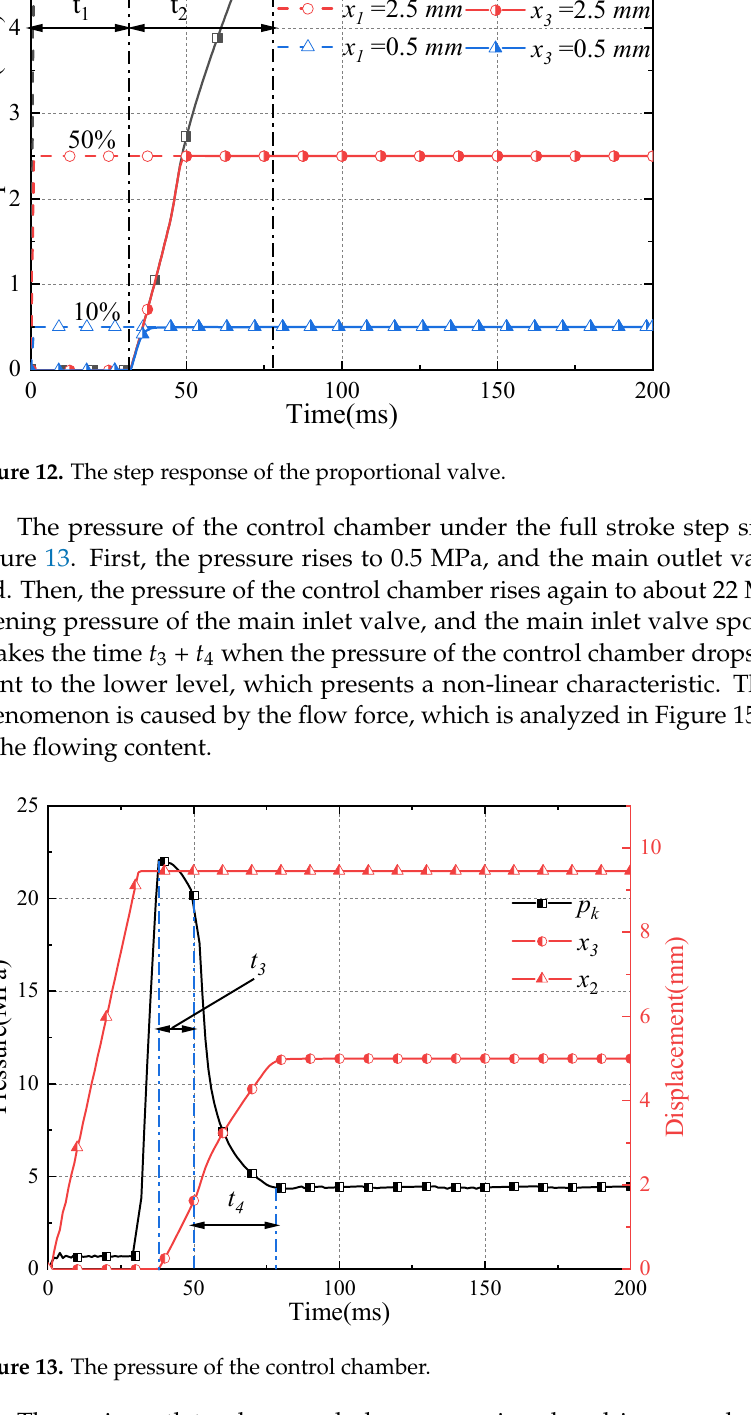
10 of 17 Figure 11. Response of test result under ramp signal. There is a high agreement by comparing the simulation and test results. Therefore, the reliability of the simulation model can be verified at 14 MPa and 25 MPa respective- ly. 4. Performance Prediction In this section, the performance of the proportional valve under rated conditions will be predicted through the simulation model verified in the previous section. The rat- ed flow rate is set to be 1000 L/min, and the nominal pressure is 31.5 MPa. 4.1. Performance Analysis Figure 12 depicts the step response characteristics of the proportional valve. t 1